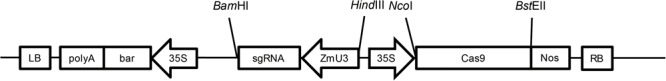
The T-DNA region of the pCAMBIA3301-Cas9-MS8ex2 plasmid. The codon-optimized Streptococcus pyogenes Cas9 (SpCas9) gene was inserted into the pCAMBIA3301 plasmid at NcoI and BstEII sites after the 35S promoter. The ZmU3::sgRNA was inserted into the BamHI and HindIII sites. LB, T-DNA left border; polyA, 35S polyA terminator; bar, bar gene; 35S, CaMV 35S promoter; sgRNA, single guide RNA; ZmU3, Zea mays U3 promoter; Cas9, Streptococcus pyogenes Cas9 gene; Nos, Nos terminator; RB, T-DNA right border; BamHI, HindIII, NcoI, BstEII are restriction enzyme sites.